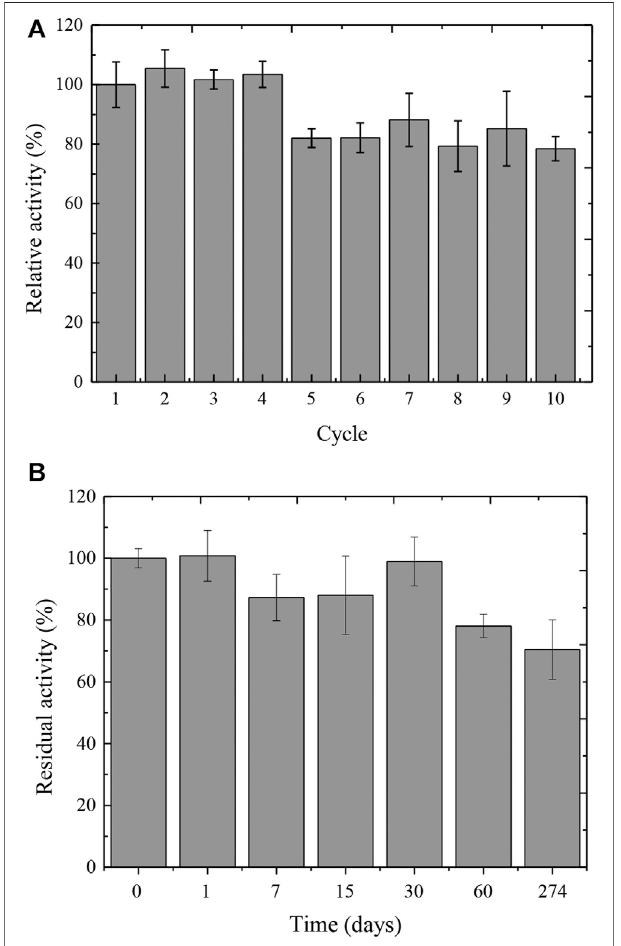
FIGURE 3 | Reuse (A) and storage stability (B) of the Ca-alginate derivative containing A. fumigatus CAS21 tannase.